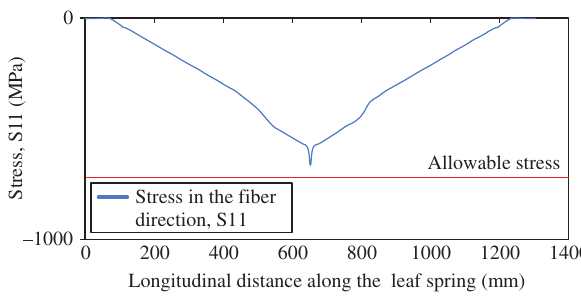
Figure 8: S11 stress distribution on the glass and carbon fiber/epoxy leaf spring upper surface along the longitudinal length.